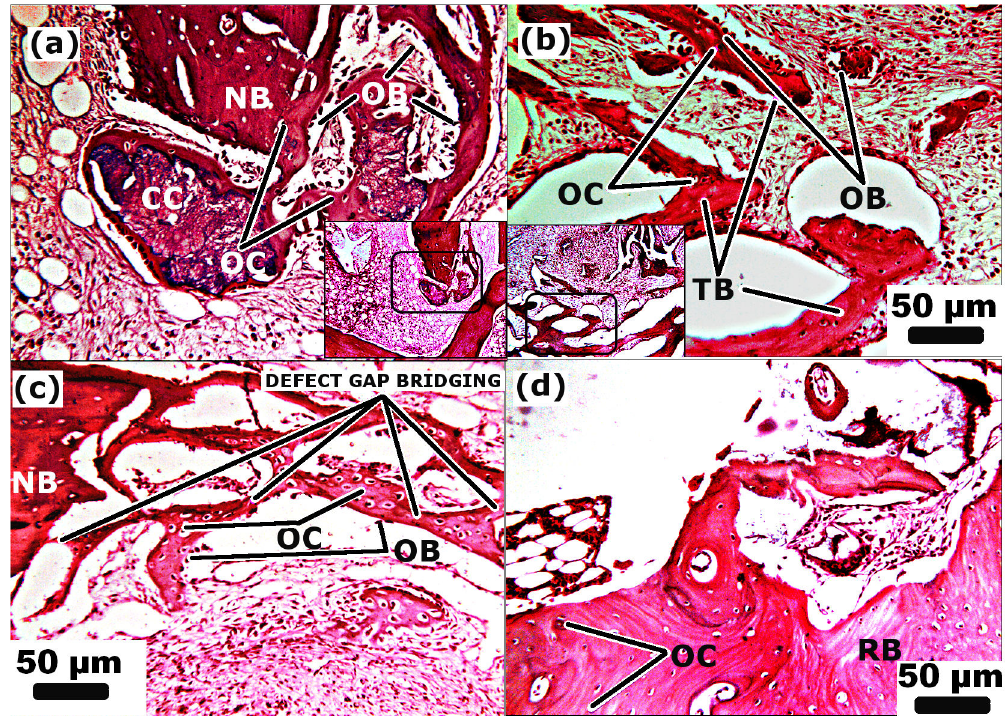
Figure 8. Histology illustrating hematoxylin and eosin (H&E) stained section of n-HA/gel/CMC treated site after week 04, 07, 10 and 14 (a,b,c,d) respectively. Bone forming tissue migrates from periphery to the centre thus initiated bone-bridging. NB: new bone, OB: osteoblast, OC: osteocyte. CC: calcified cartilage, TB: trabecular bone, RB: remodeled bone. Scale Bar: 50µm (magnification=125X, inset magnification=50X).